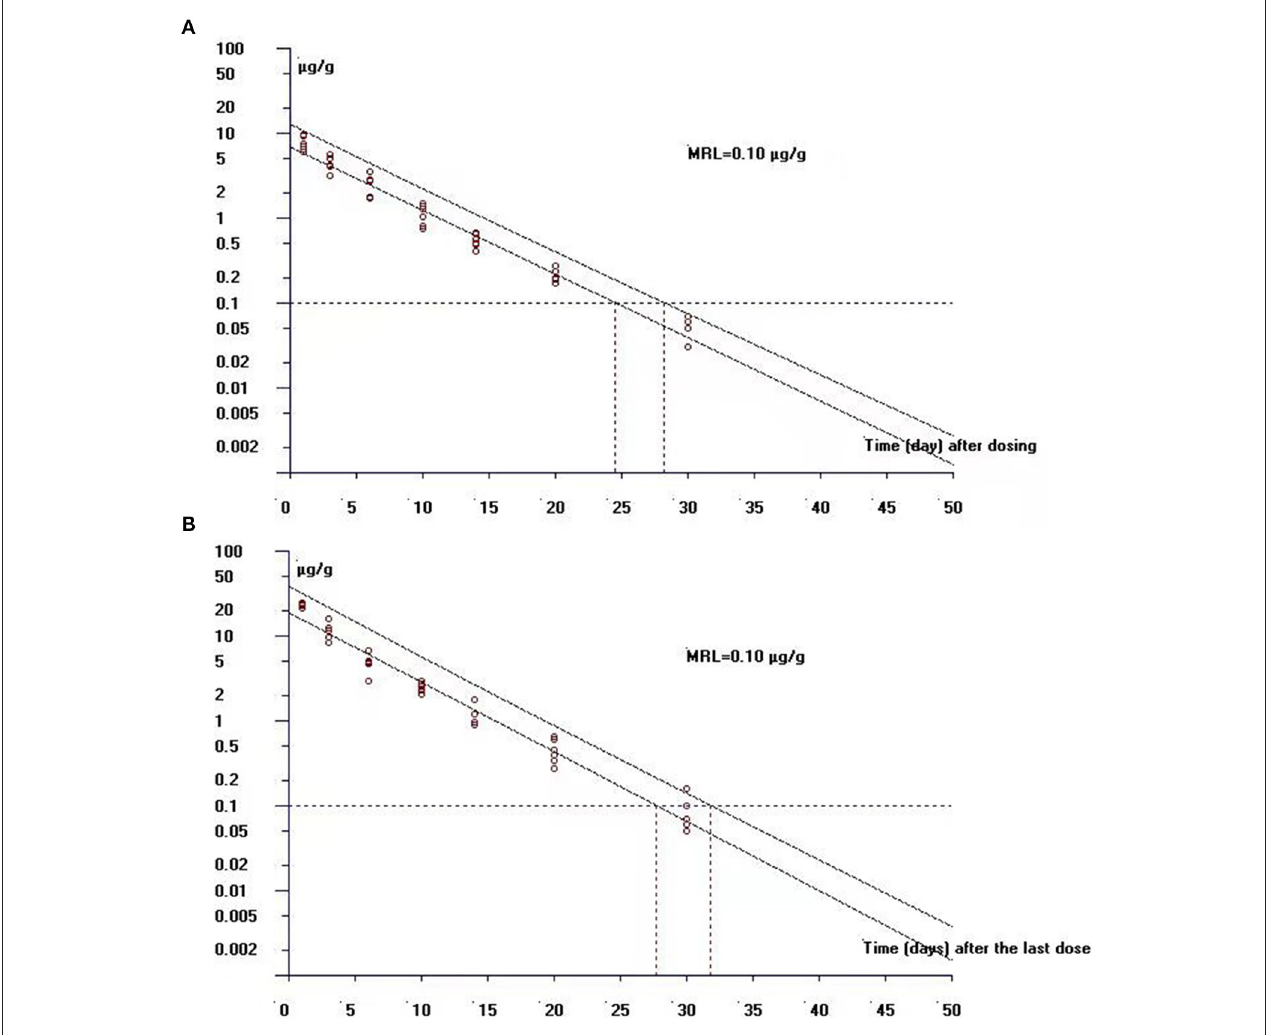
FIGURE 6 | The theoretical withdrawal periods of enrofloxacin in crucian carp after (A) single (20 mg/kg b.w.) and (B) multiple dose (20 mg/kg b.w. daily for 5 days) oral administration at 28 ◦